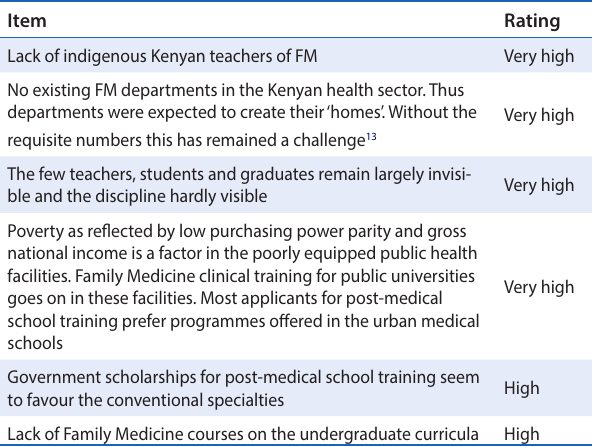
Table 3: Challenges and barriers in the development of Family Medicine in Kenya